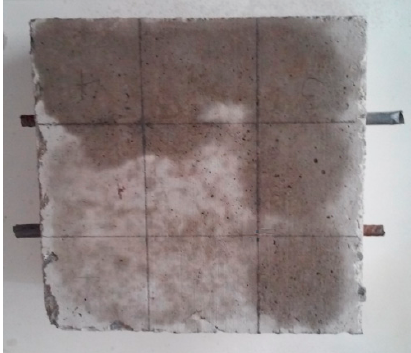
Figure 7. Photograph of an example of test specimen A.